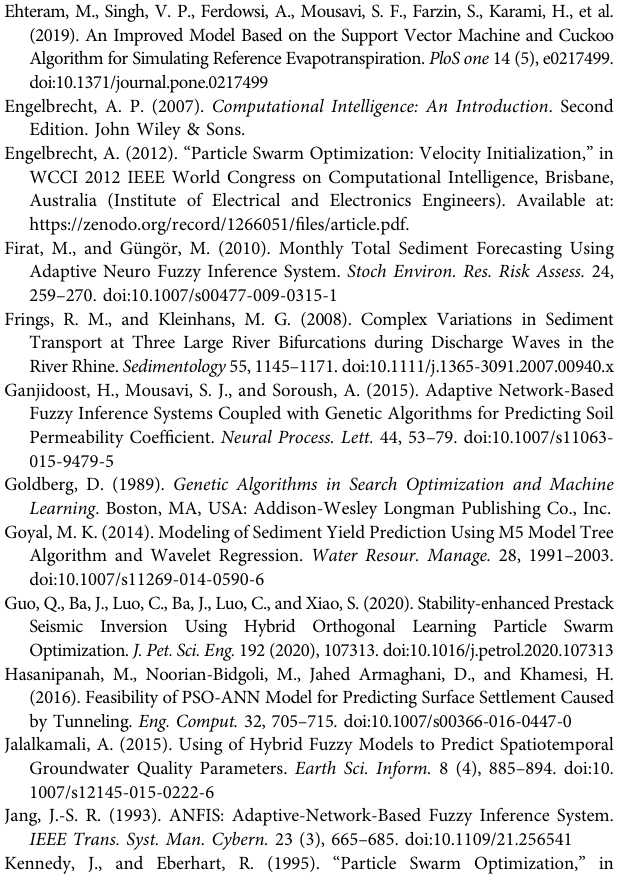
Algorithm for Simulating Reference Evapotranspiration. PloS one 14 (5), e0217499.